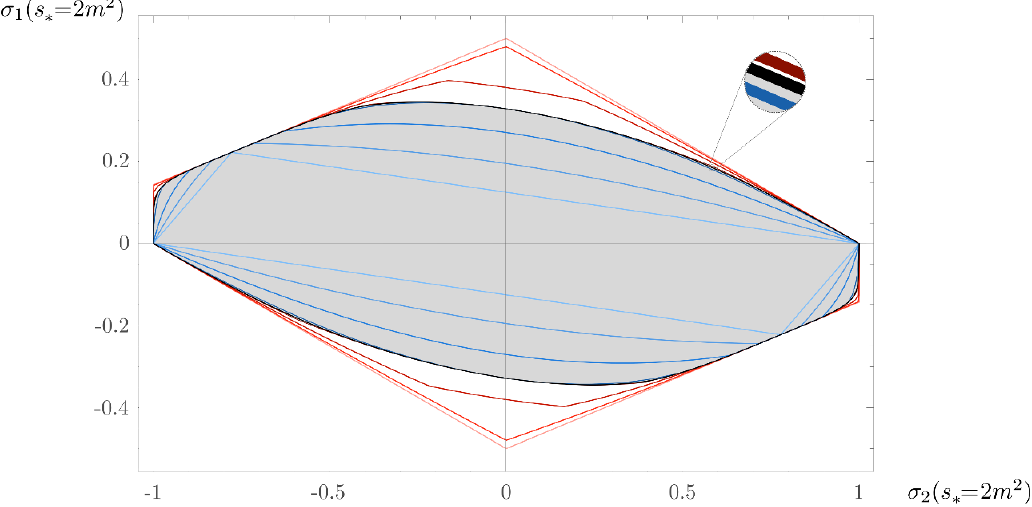
Figure 4 . Two-dimensional section of the monolith we call the O( N ) slate obtained at s (cid:3) = 2 m 2 ( (cid:18) (cid:3) = i(cid:25)= 2) in the (cid:27) i decomposition of (A.2) for N = 7. In black we show the optimal bound to which the primal and dual problems converge respectively from below or above. Consistent S- matrices lie on the shaded region in grey. In blue (red) we present various bounds as we take periodic ansatze in the primal (dual) problem. From lighter to darker colors we have period (cid:28) = 0 ; 4 ; 6 ; 10 : 25.